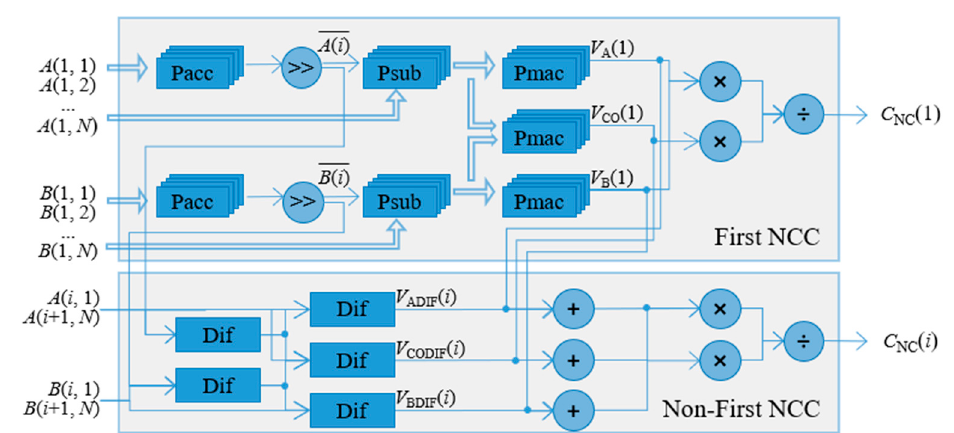
Figure 4. NCC parallel processing architecture. Dif: difference, Pacc: parallel accumulator, Pmac: parallel multiply-accumulator, Psub: parallel subtractor.